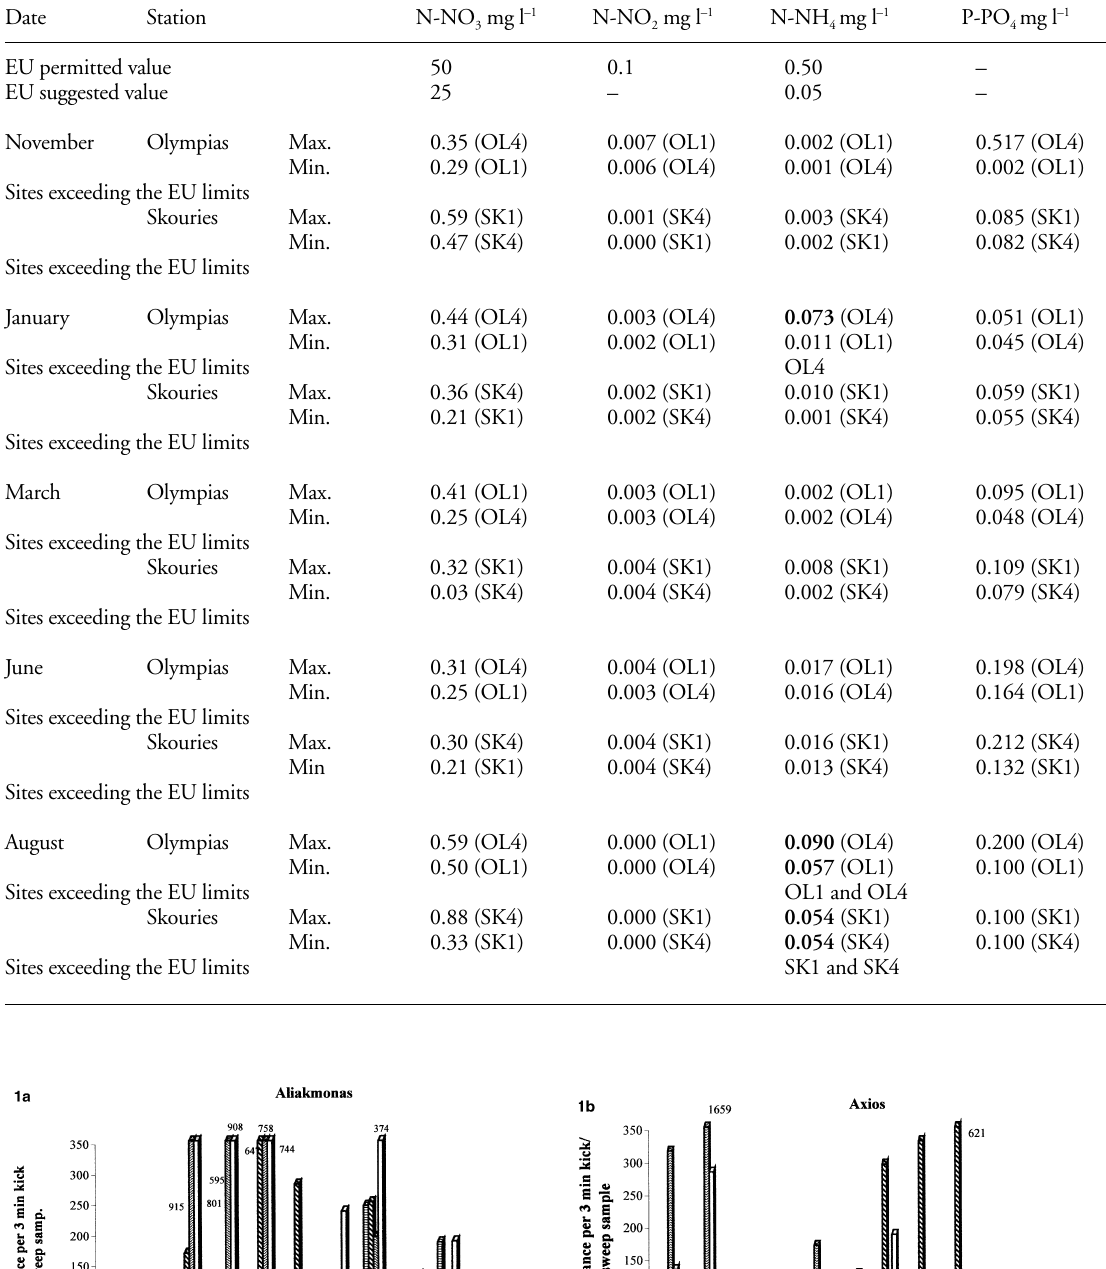
Table 9. Nutrients at Olympias and Skouries areas (bold values: values exceeding the EU limits).